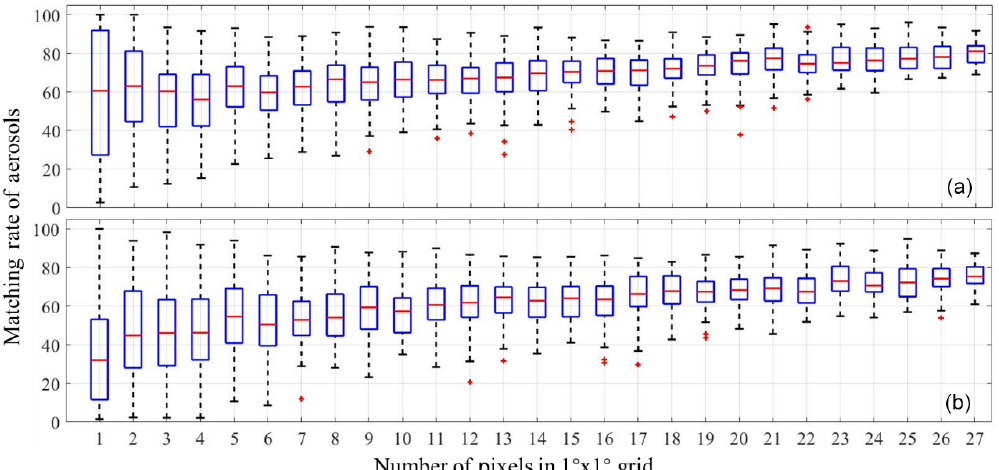
Figure 4. Matching rates of aerosols as a function of number of samples in 1 ◦ grid cells for reconstructions of nadir profiles with 30km dead zone (a) and 100km dead zone (b) . Boundaries of each box represent the 25th and 75th percentiles of the sample data in the grid, red lines indicate medians, and whiskers correspond to approximately ± 2 . 7 σ (99.3% coverage, assuming that data are distributed normally). Points marked with “ + ” are extreme